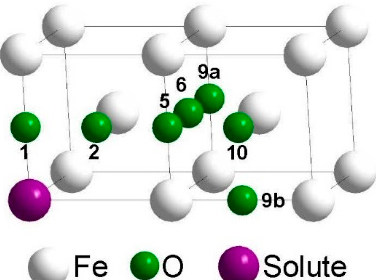
Figure 1. Denotation of octahedral interstitial sites in the neighborhood of a substitutional solute (up to 10 th neighbor shell).